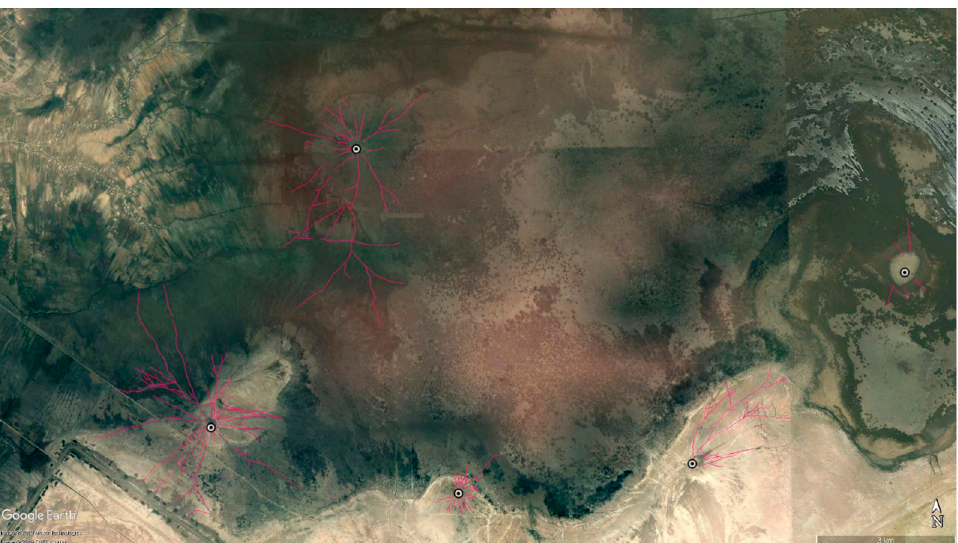
Figure 8. While tracing hollow ways around known archaeological sites, occasionally, as in this image, radial formations of hollow ways would highlight the locations of undocumented radial formations of hollow ways would highlight the locations of undocumented archaeological archaeological sites. This mainly occurred where we were able to survey through shallow water.